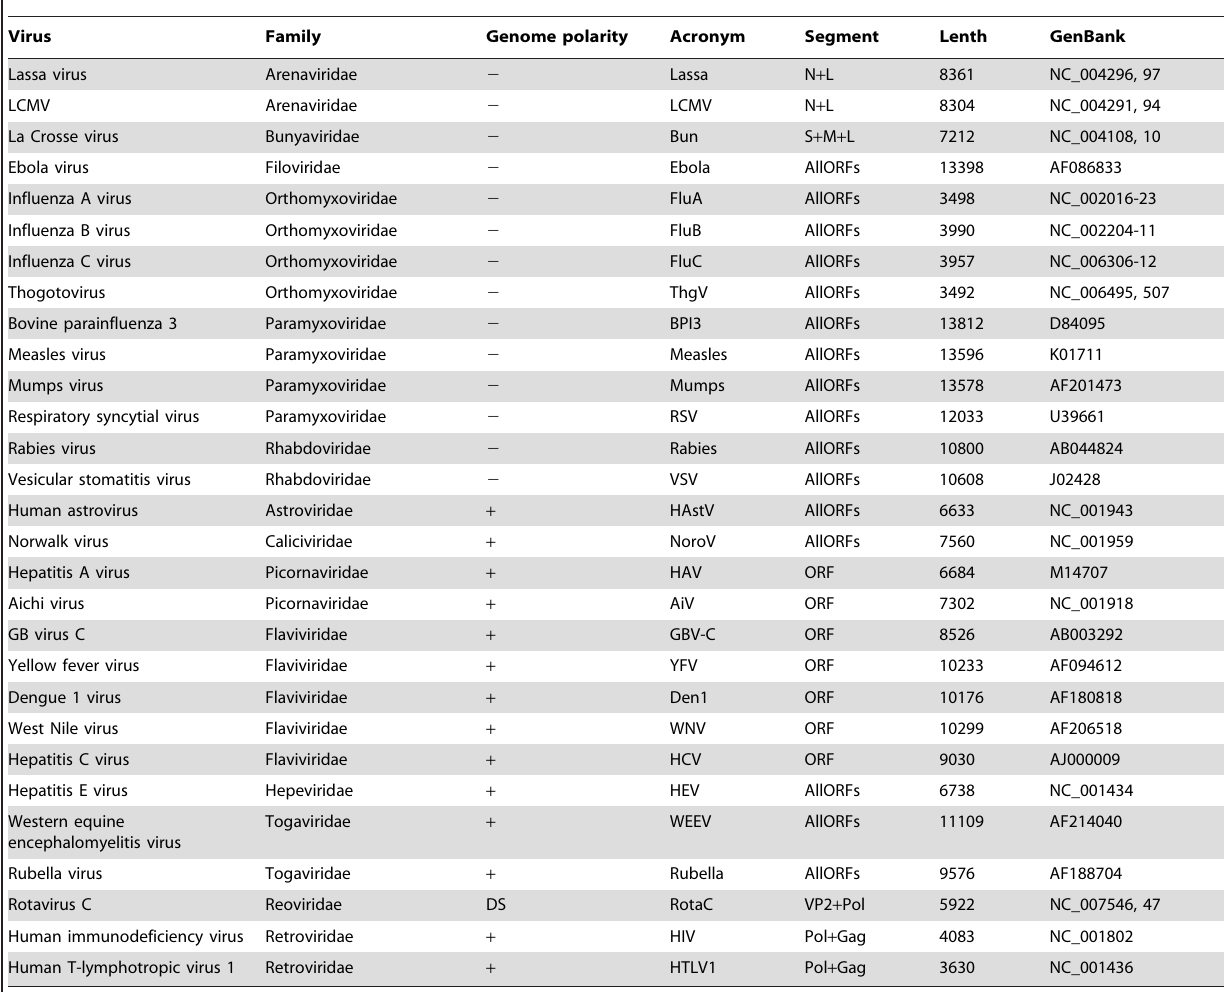
Table 1. Virus sequences used in this